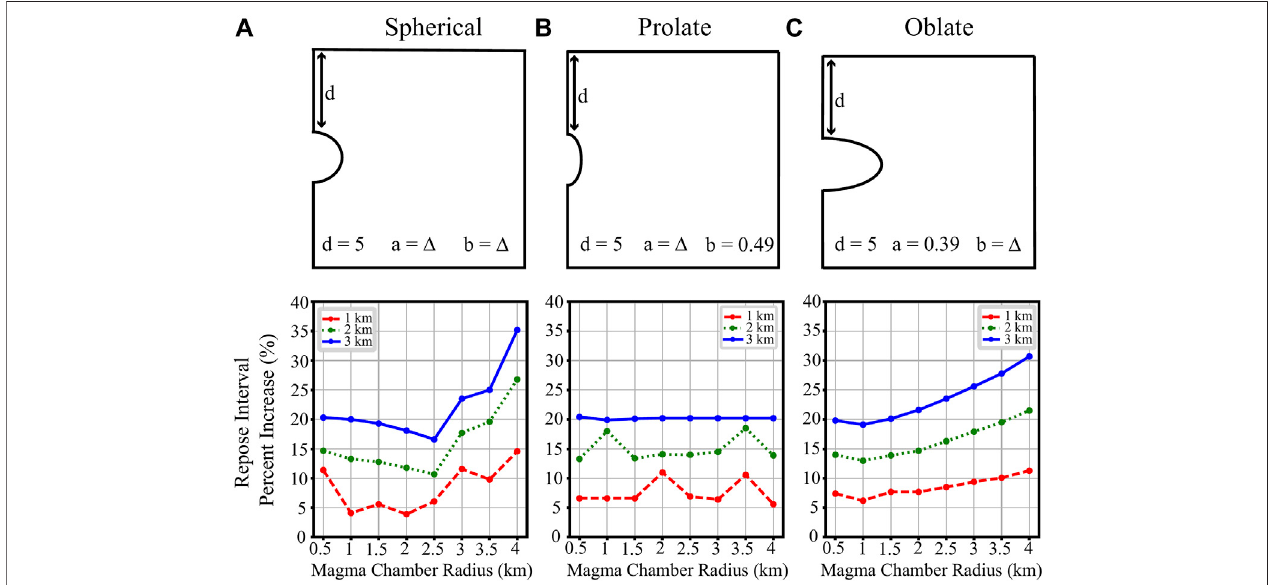
FIGURE6| Magmachamberradius versuspercent changeinrepose intervalofvolcanic systemswithspherical,prolate, and oblate magmachamber geometries. Ineach case, avolcanicsystemwithadepthof5 kmtothecrestofthemagmachamber anda0.0024 km 3 /year fl uxrateismodeled.Themagmachamberradii change for each of the spherical, prolate and oblate chamber systems. (A) In the spherical system, the horizontal and vertical radii are identical lengths and range from 0.5 to 4 km.Thepercentincreaseofreposeintervalfromthepresenceoftheglacierslightlydecreaseswhentheradiusisincreasedfrom0.5to2 kmlengthandincreases whentheradiusisincreasedfrom2to4 km. (B) Intheprolatesystem,thehorizontalradiusremains~0.49 kmwhiletheverticalradiusrangesbetween0.5and4 km. (C) Theverticalradiusforanoblatemagmachambersystemisheldconstantat~0.39 kmwhilethehorizontalradiusrangesbetween0.5and4 km.Reposeintervalpercent change increases as the horizontal radius of an oblate magma chamber is increased in